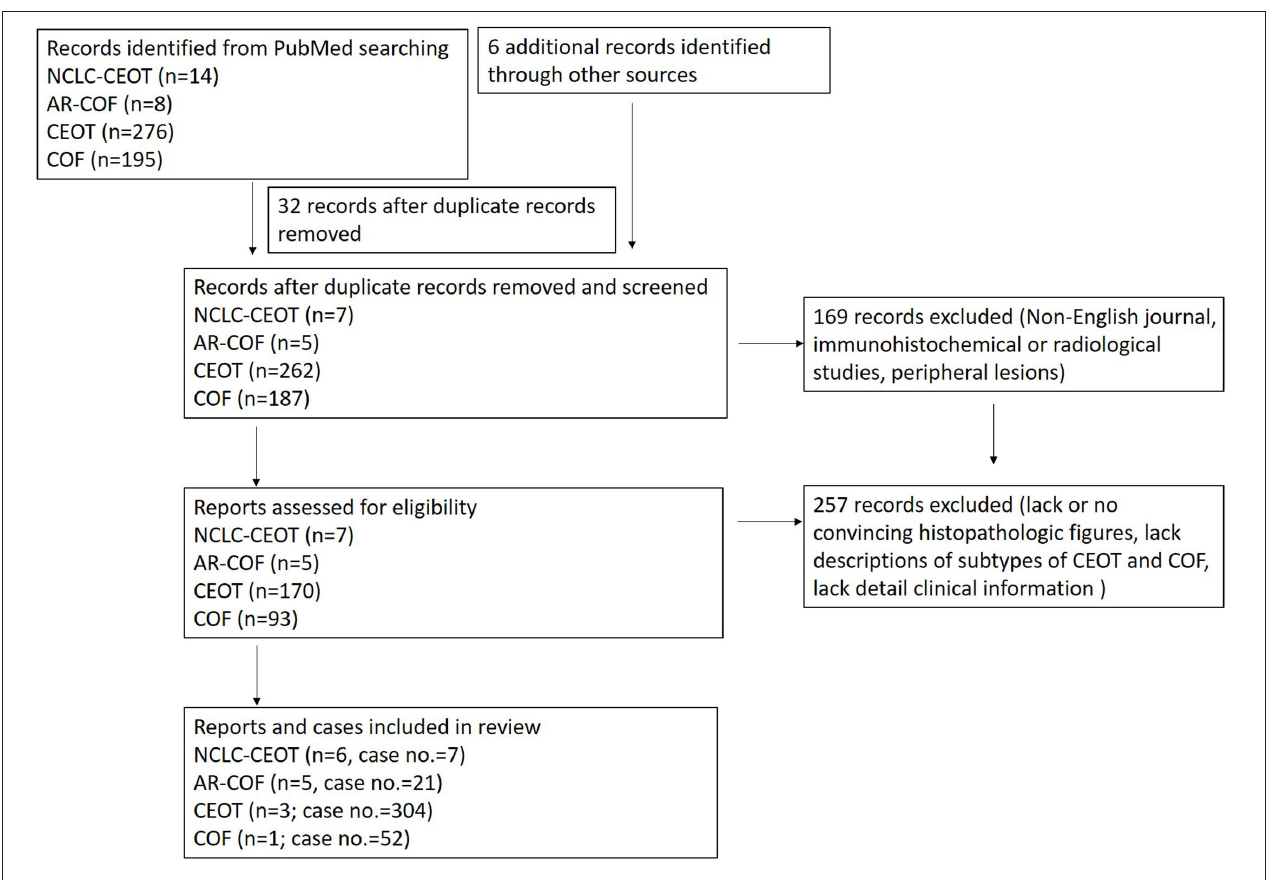
FIGURE 2 | Study screening